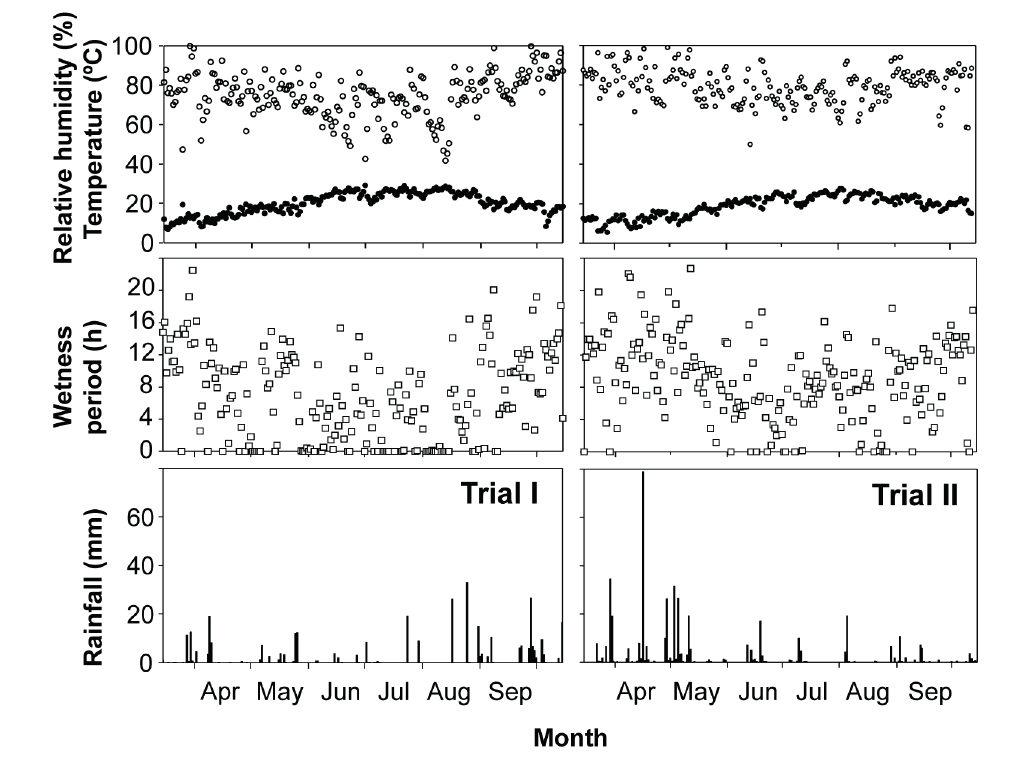
Figure 1. Dynamics of daily mean relative humidity ( ○ ), mean temperature ( l ), duration of wetness periods and rainfall in trials I and